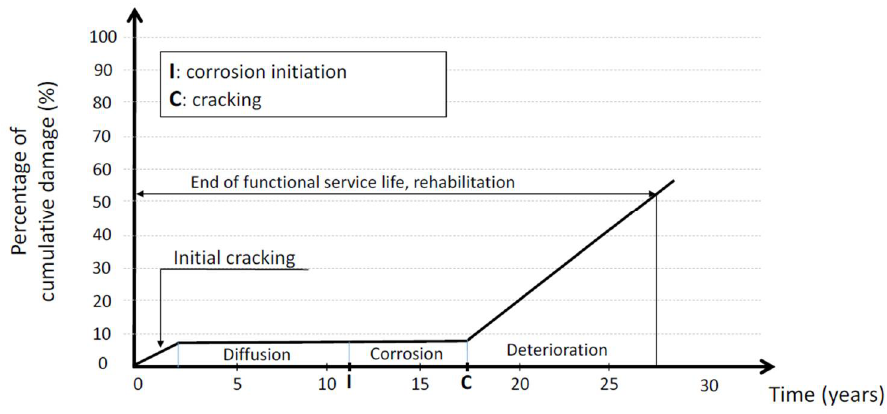
Figure 6. Degradation of reinforced concrete [43].